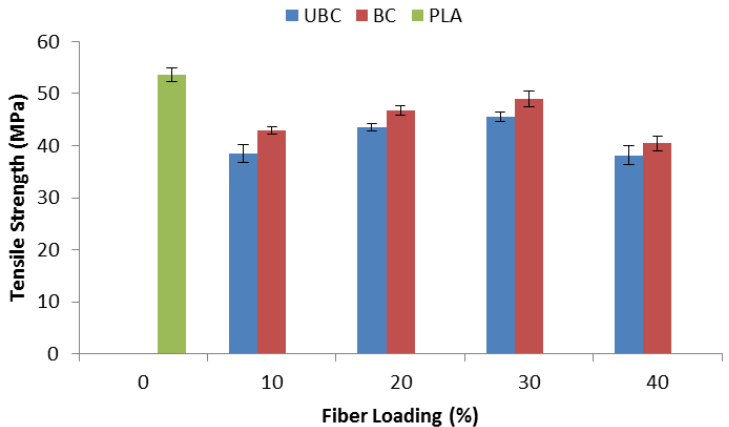
Figure 4. Tensile strength of pure PLA, UBC and BC composites.